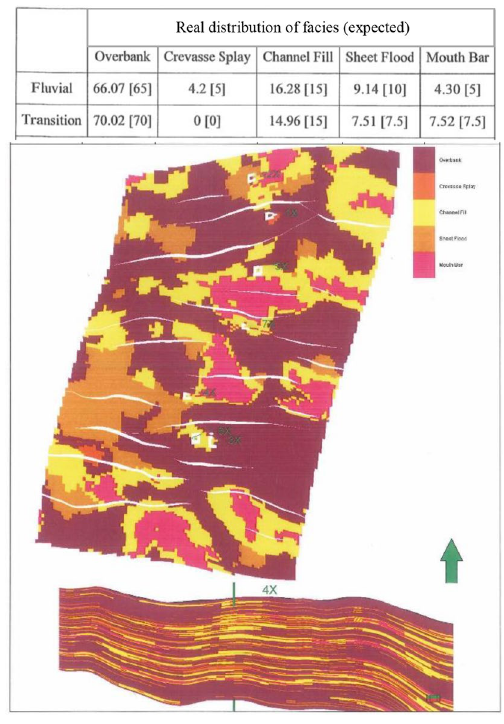
Fig. 31 Resulting model of case